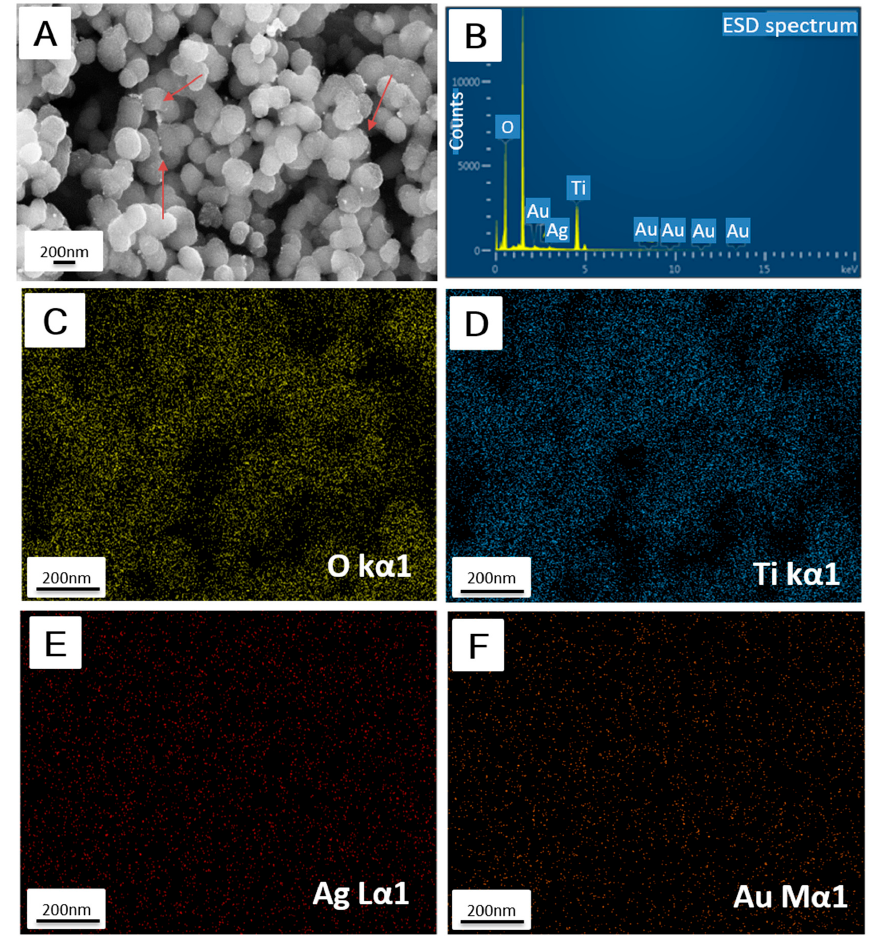
Figure 3. ( A ) SEM image and ( B ) EDS spectra of 1.18 wt% Au-1.07 wt% Ag-decorated TiO 2 composites; ( C – F ) EDS mapping analysis of component elements from a SEM image ( A ) of Au-Ag decorated on TiO 2 composites showing the distribution of Ti, O, Ag, and